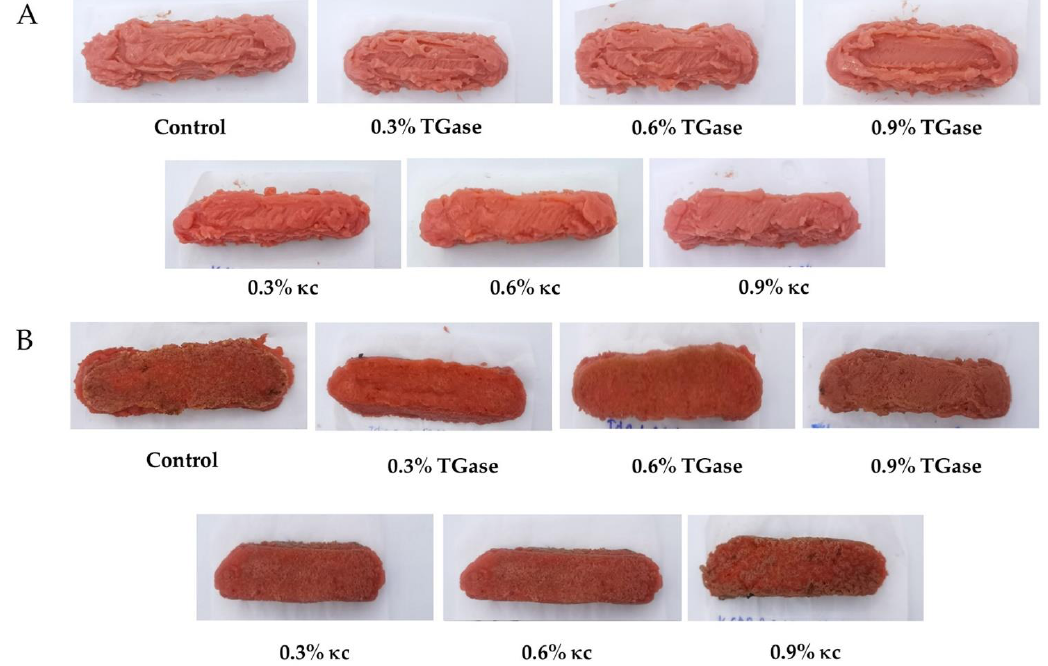
Figure 4. Appearances of ( A ) raw and ( B ) cooked meat mimics treated with TGase and κ c at 0, 0.3, 0.6 and 0.9%.